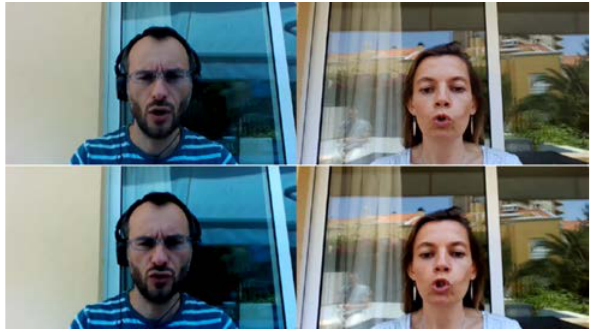
Figure 6 | Example of two speakers before (upper panel) and after (lower panel) visual synchronization. In the latter, both speakers pronounce the same phoneme and hence their realizations (e.g., lips rounding) can be efficiently